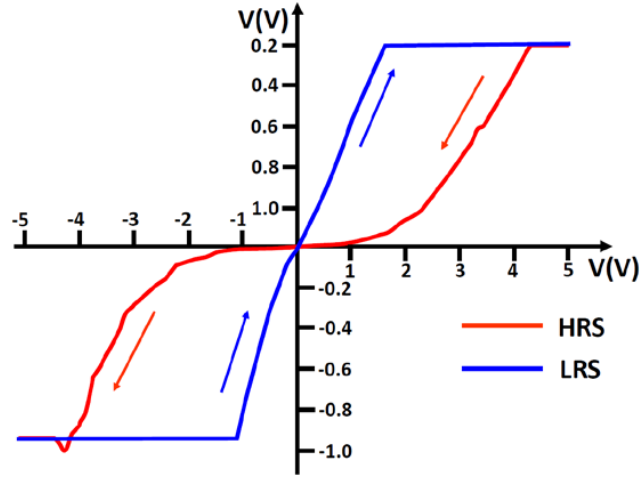
Figure 65. The I/V curve recorded during reversible switching inside of the electric-modified grain of the TiO 2 surface. Adapted from [53].